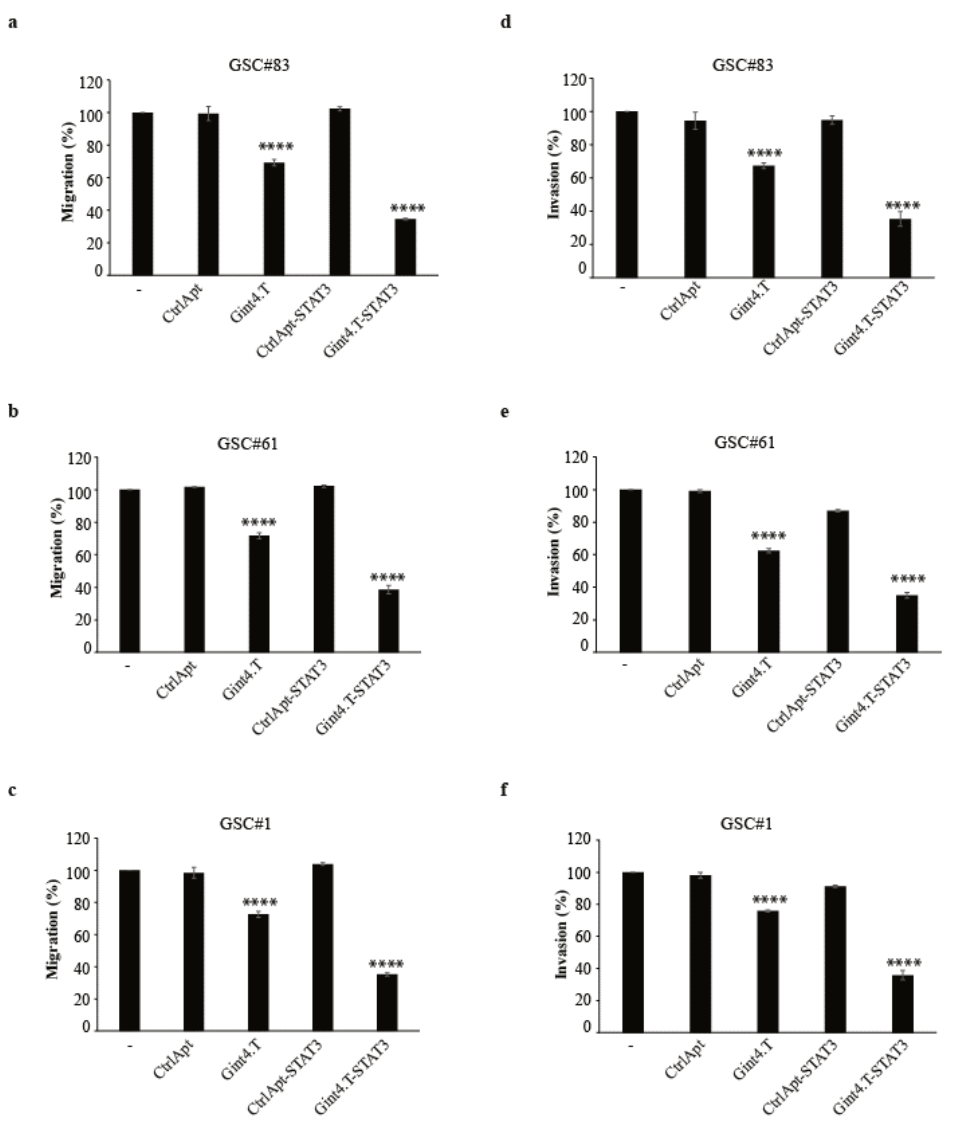
Figure 4. Gint4.T-STAT3 effect on GSC migration and invasion. Cell motility ( a – c ) or invasion ( d – f ) of indicated GSCs (PDGFR β + ) left untreated or treated with indicated aptamers or conjugates (400 nmol/L) for 24 h was analysed. The results are expressed as the percentage of the migrated/invaded cells with respect to the untreated cells. In ( a – f ), vertical bars indicate the standard deviation values ( n = 3). Statistics were obtained by one-way ANOVA (versus control conjugate): ****, p < 0.0001.